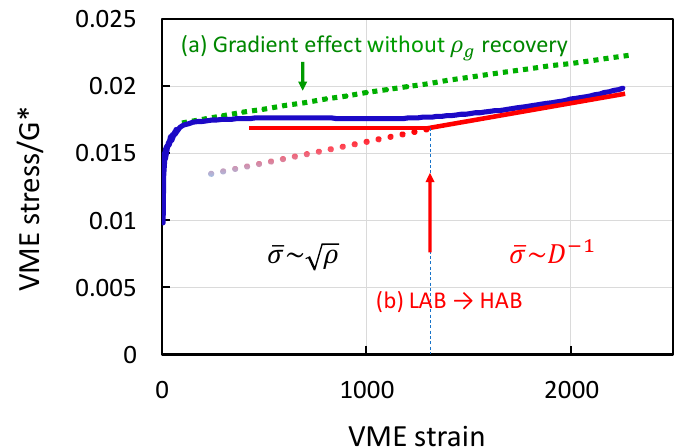
Figure 9. Expected behavior at ultra-severe plastic deformation (SPD) by assuming flow stress control from either ( a ) saturated statistically stored dislocation density plus geometrically necessary dislocations (GND) density from the HPT shear gradient, Equation (17) or ( b ) from the 3D dislocation density (cells or subgrains) during Stage IV and from the grain size beyond Stage IV (ultra-SPD range).